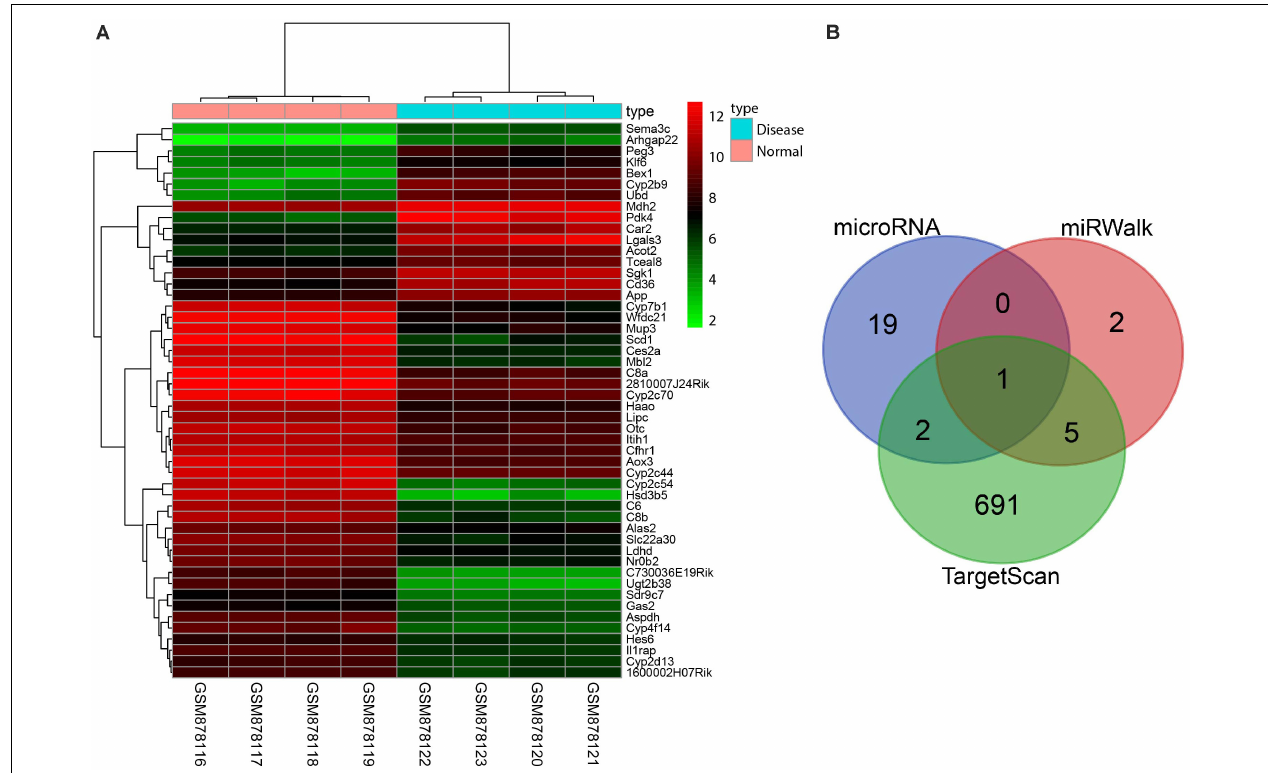
FIGURE 1 | Bioinformatics analysis shows that PEG3 is highly expressed and can be targeted by miR-129-5p. (A) Heap map displaying the top 50 differentially expressed genes in GSE35961. The X-axis represents sample number. The Y-axis represents the gene name. Each small square in the graph represents the expression of a gene in a sample; the left dendrogram represents the gene clustering, while the upper dendrogram represents the sample clustering. The right histogram shows the color gradation. (B) Venn diagram illustrating miRNAs that can target PEG3. PEG3, paternally expressed gene 3; GSE, Gene Expression Omnibus